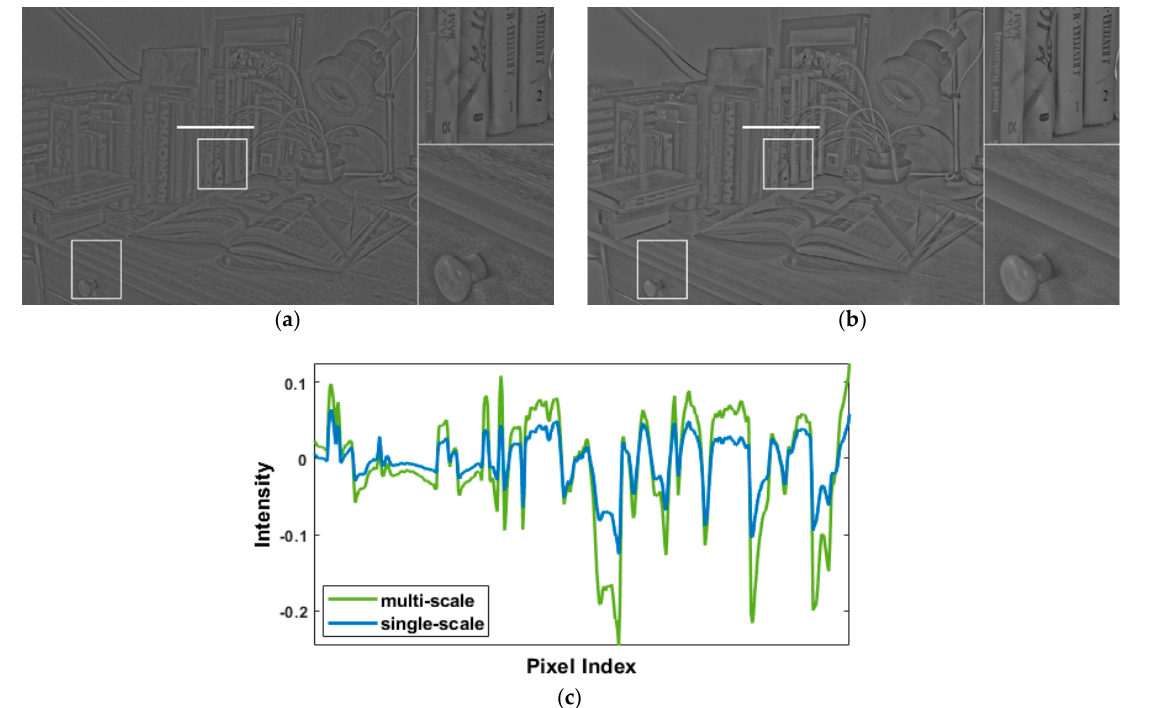
Figure 3. Comparison of the effect between single-scale and multiscale detail extraction using the test image Cadik_Desk02 shown in Section 4.2 ( a ) Result of single-scale-based detail extraction (performed in [24]). ( b ) Result of multiscale-based extraction (performed in the proposed method). ( c ) The pixel value of the detail plane along the horizontal white line segments on ( a ) and ( b ). In ( a ) and ( b ), the right-side images are the enlarged version of the white rectangles, which are suggested to be closely examined by the reader.